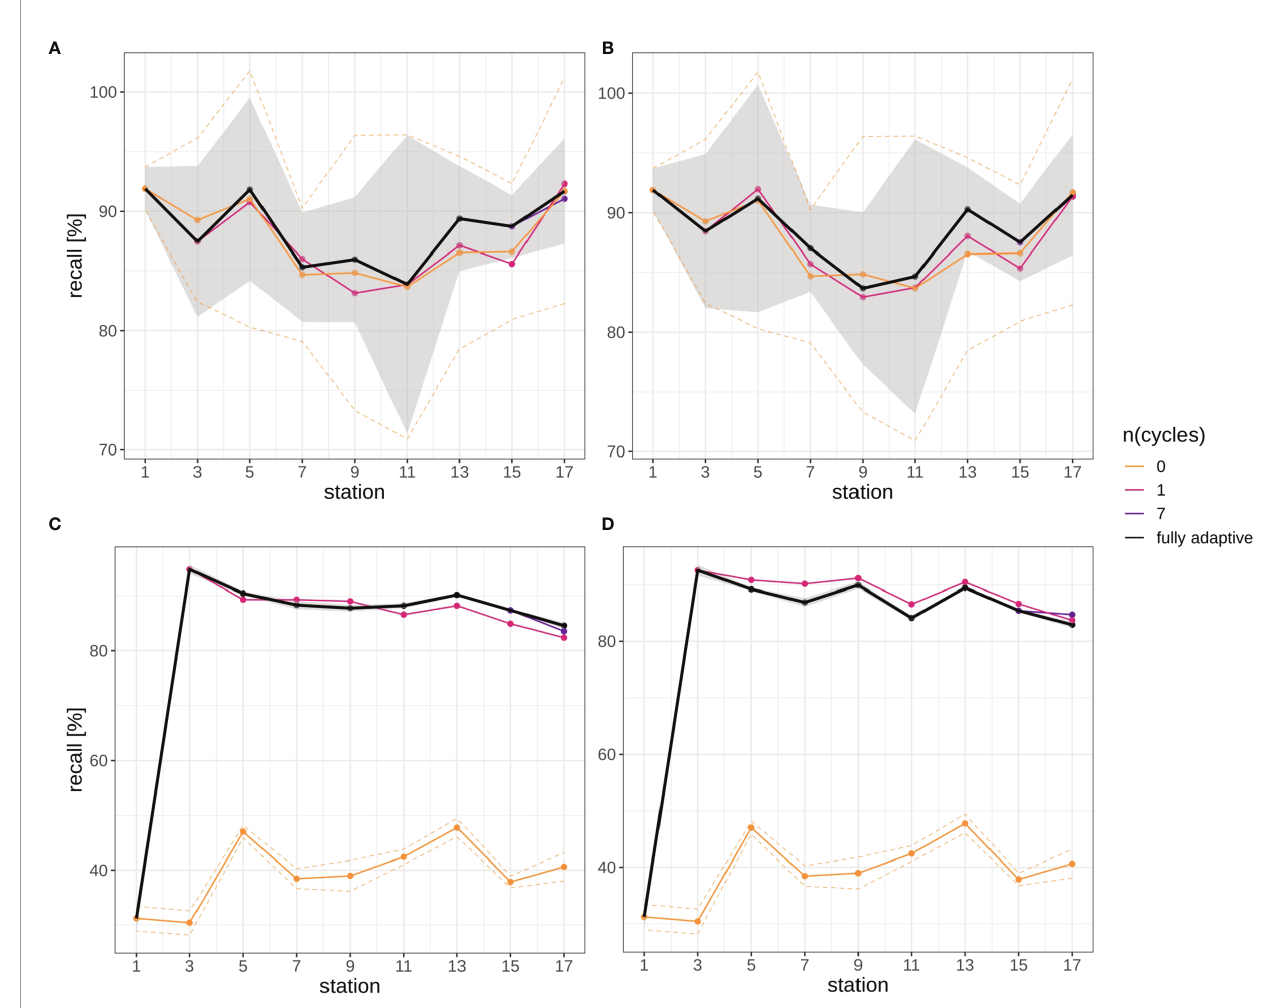
FIGURE 5 | Recall trajectories for different modes of adaptation using the DOC. Solid black line represents weighted mean of the fully-adaptive implementation, grey area denotes the corresponding weighted standard deviation. Colored solid and dashed lines represent weighted mean and weighted standard deviation of less- adaptive implementations (denoted by the number of adaptation cycles). (A) : September survey, fi rst replicate, (B) September survey, second replicate; (C) : December survey, fi rst replicate, (D) : December survey, second replicate. Replicates differ in the random selection of images for training-set updates and random parameter initializations of models before training (see Case Studies – North Sea Surveys ). Trajectories for all nine adaptation modes are shown in Figure SI XI/1 . Note that weighted standard deviation for the fully-adaptive implementation in the December survey is very small compared to that in the September